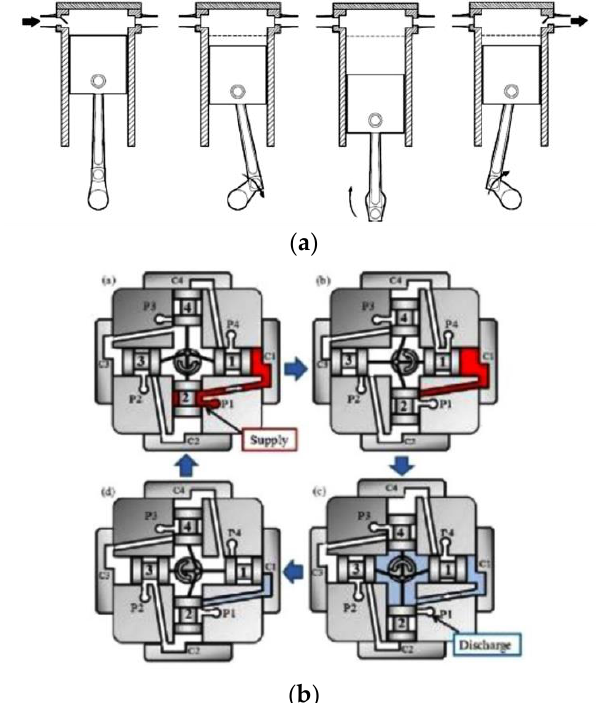
Figure 15. Two-phase reciprocating piston expander, with the principle of operation for an axial device ( a ) and a radial one ( b ) [45].